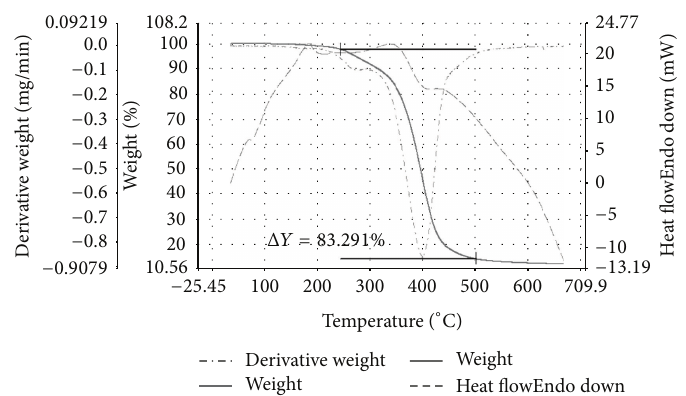
Figure 5: TGA thermogram of polymer.